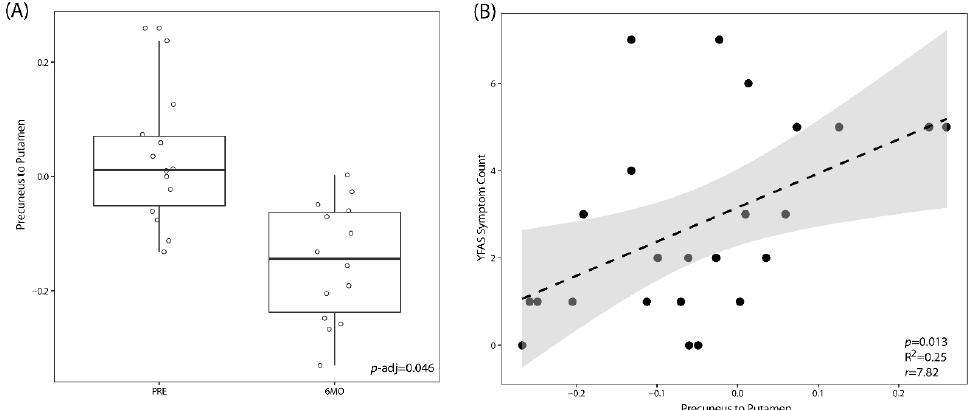
Figure 3. LSG leads to a significant decrease in the resting-state connectivity between the precuneus and the putamen. ( A ) Box plot showing resting-state connectivity between the precuneus and the putamen at baseline (PRE) versus those at 6 months (6MO) post bariatric surgery. p -Values are adjusted for multiple hypothesis testing. ( B ) Linear correlation between resting state connectivity between the precuneus and the putamen to food addiction behavior as measured by the Yale Food Addiction Scale (YFAS).